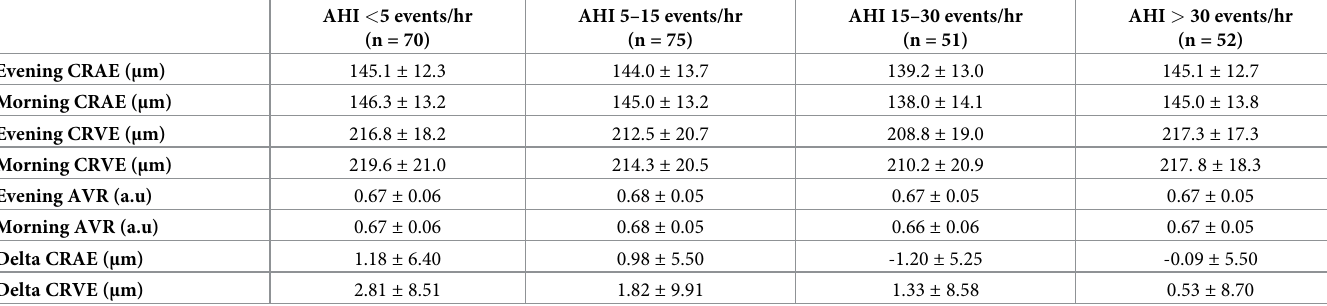
Table 2. Main group data for evening, morning and overnight change in CRAE and CRVE and AVR grouped by AHI